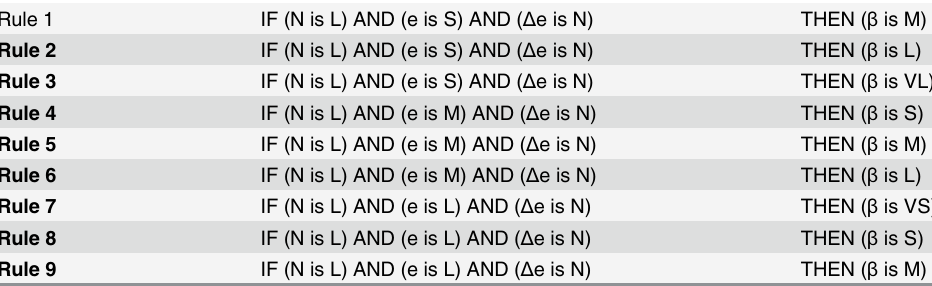
Table 1. Fuzzy-expert rules in linguistic form.